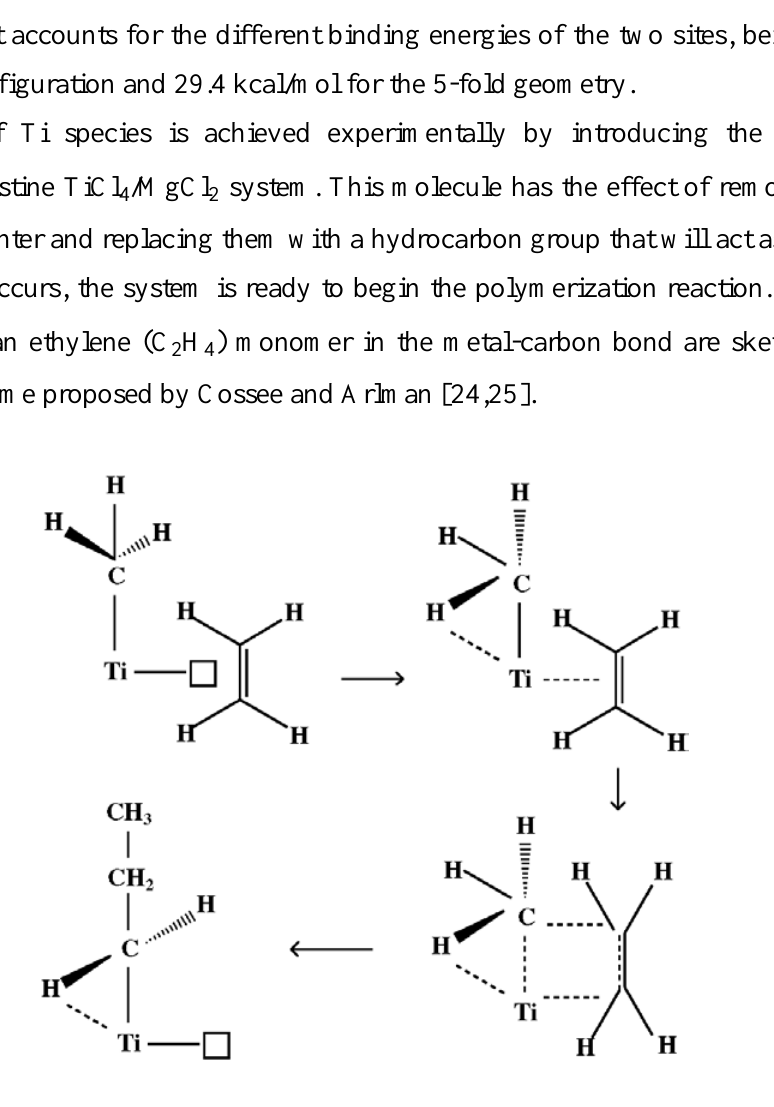
Figure 3. The reaction path leading to the insertion of an ethylene molecule in an active Ti catalytic center. The reaction proceeds along the direction indicated by the arrows and the open square indicates the vacant site. The Ti-H dashed lines in the lower panels represent schematically the agostic interac- tion described in the